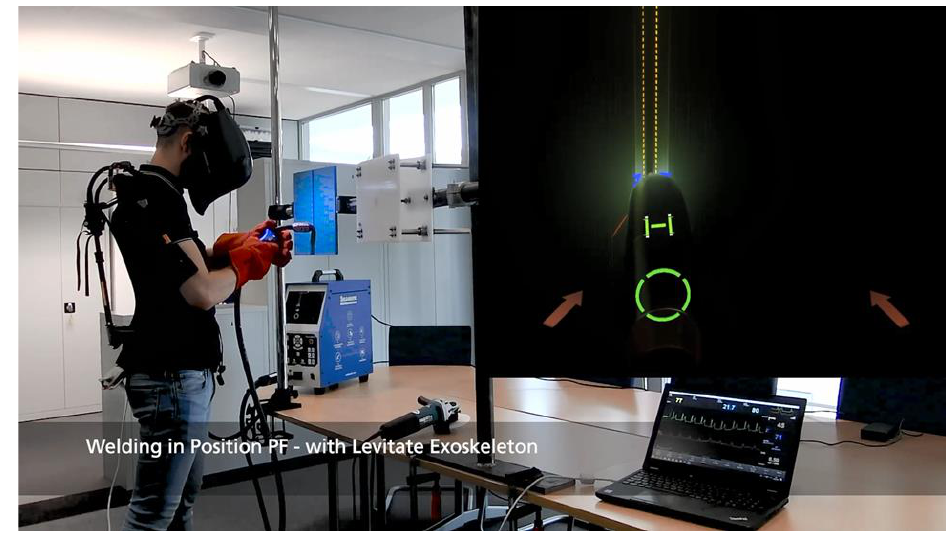
Figure 1. Exemplary illustration of the Position PF during the welding sequence including first-person perspective of the subject. Fraunhofer IPA.